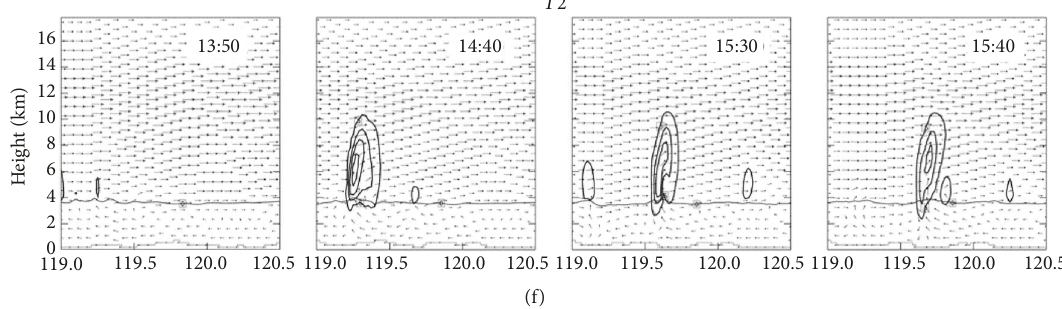
Figure 10: Cross section of the simulated graupel water mixing ratio (solid line, minimum 0.5 g ⋅ kg −1 , interval 3g ⋅ kg −1 ), UW wind vector, and 0 ∘ C line (thin solid line) in latitudinal direction based on the different schemes: (a) the original scheme; (b) Philips; (c) Cooper; (d) Fletcher; (e) Chi NJ; and (f) Chi Mt. H.